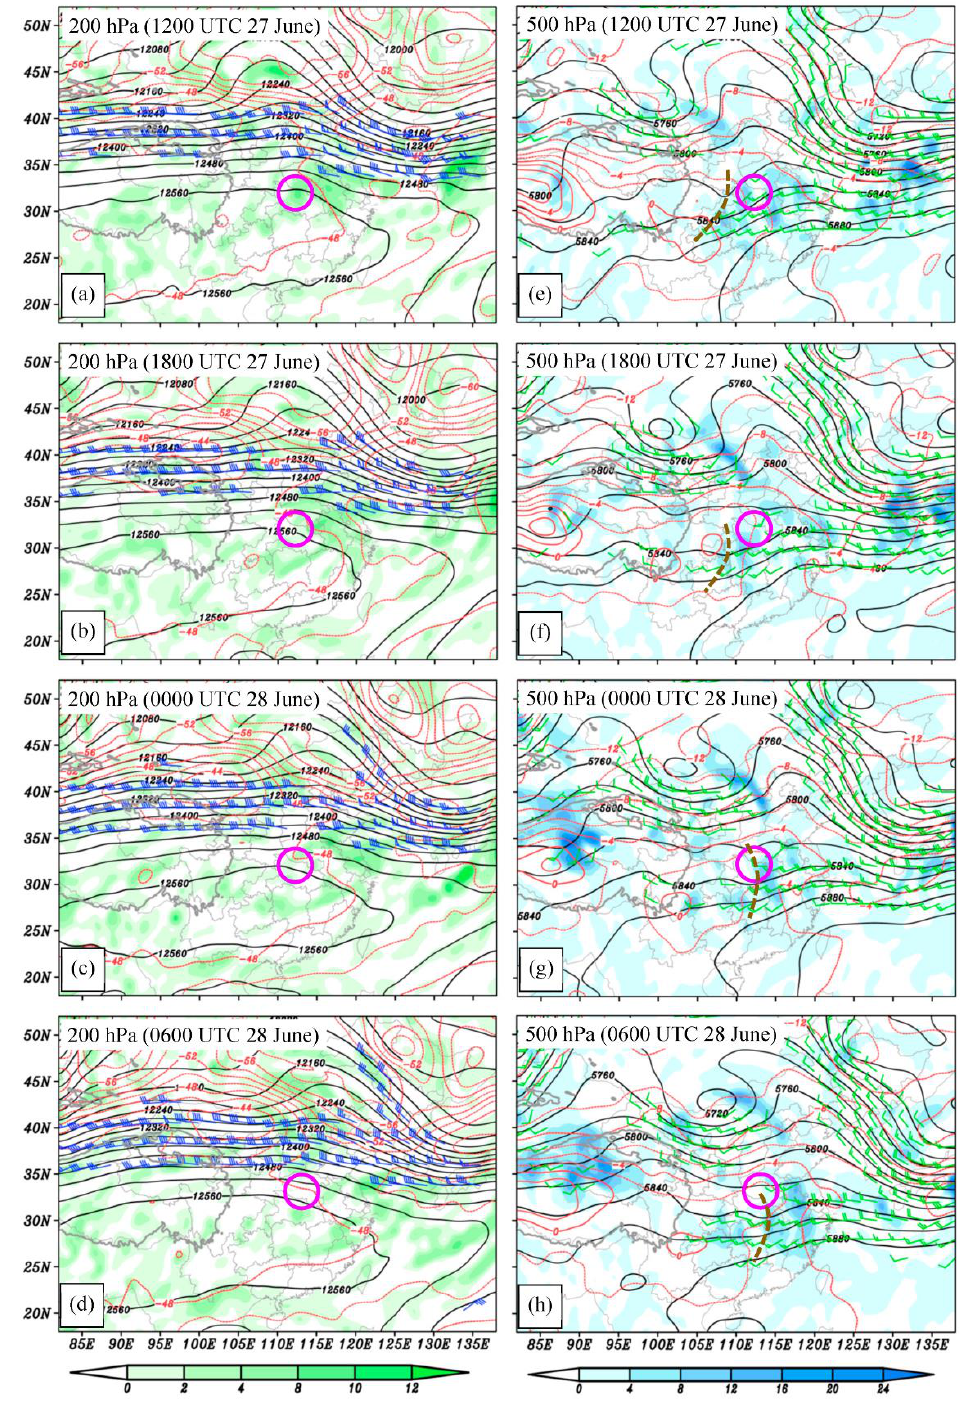
Figure 3. Panels ( a – d ) show the 200-hPa divergence (shading, units: 10 −5 s −1 ), wind with speed above 35 m s −1 (a full bar represents 10 m s −1 ), temperature (red lines, units: °C), and geopotential height (black lines, units: gpm). Panels ( e – h ) illustrate the 500-hPa temperature advection ( −𝐕 ∙ ∇𝑇 ) (shading, units: 10 −5 K s −1 ), wind with speed above 10 m s −1 (a full bar represents 10 m s −1 ), temperature (red lines, units: °C), and geopotential height (black lines, units: gpm). The purple circles mark the location of the mesoscale vortex.